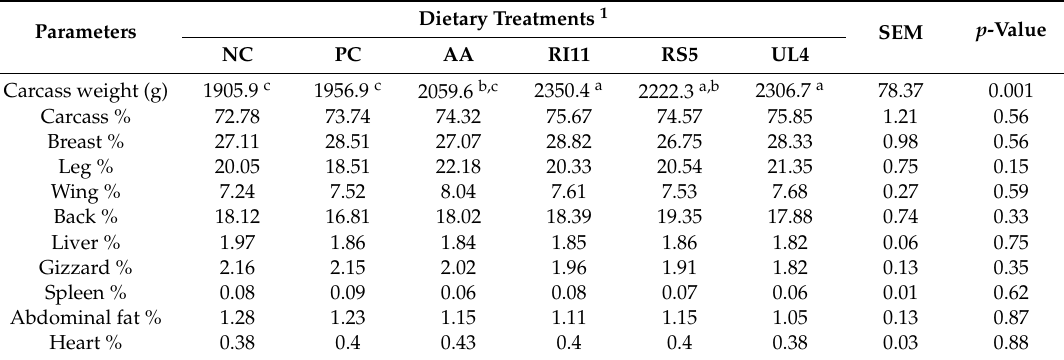
Table 5. Carcass weight and carcass yield in broiler chickens fed di ff erent postbiotics under heat stress. Parameters